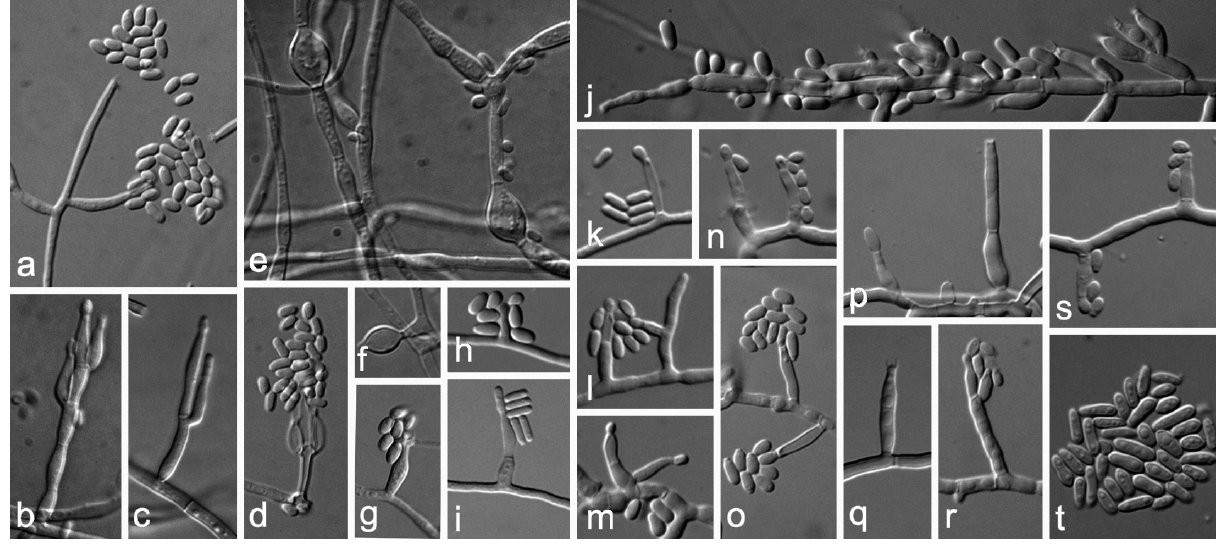
Figure 1. Cadophora luteo-olivacea . a–t, Aerial structures on MEA; a-d, conidiophores; e-f, hyphal swellings; g-s, conidiophores and phialides; t, conidia. Scale bar: a–t=10 µ m. Scale bar for a also applies to